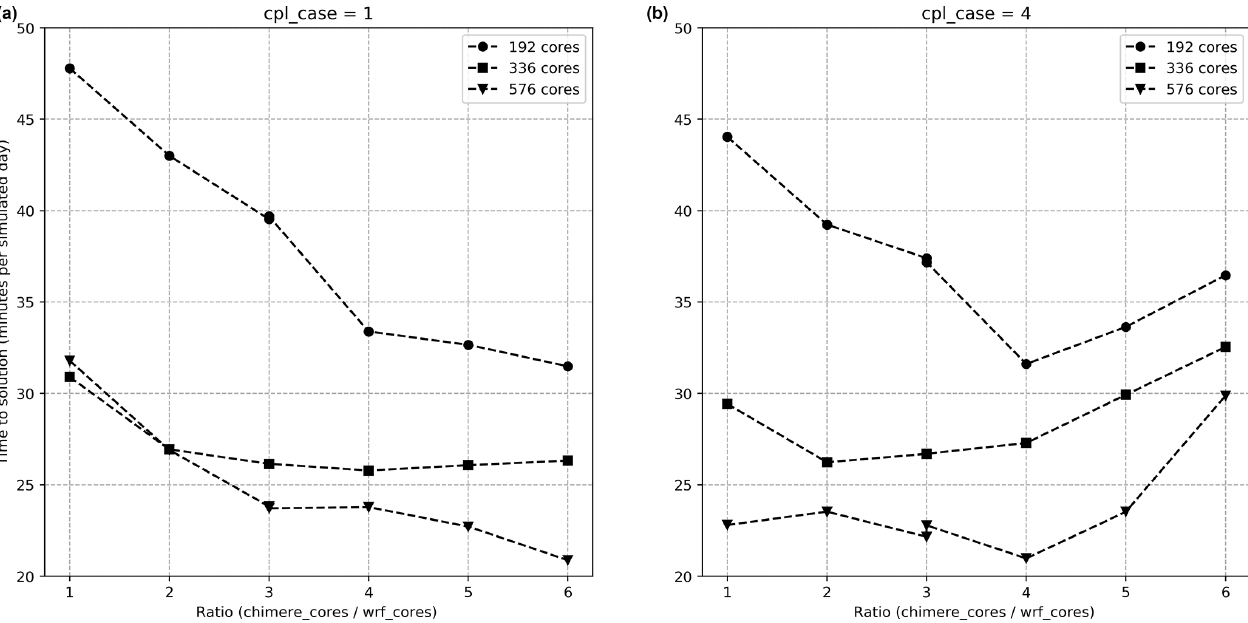
Figure 17. Time to solution for the coupled model in minutes per simulated day as a function of the ratio of CHIMERE cores to WRF cores for 192, 336, and 576 total number of cores. and for cpl _ case = 1 (a) and cpl _ case = 4 (b)